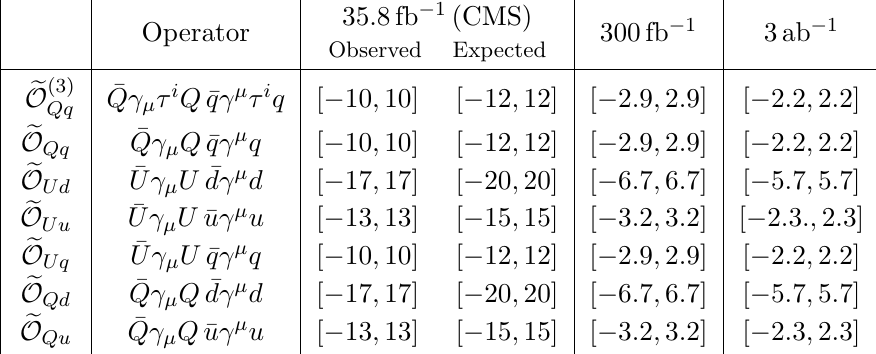
Bounds on the color singlet operators in eq. (A.1). The coe(cid:14)cients are normalized as in table 1 and eq. (3.1). Current bounds are extracted from CMS data [43] (both observed and expected), while projections correspond to the higher luminosities of 300 and 3000 fb (cid:0) 1 at p s = 13